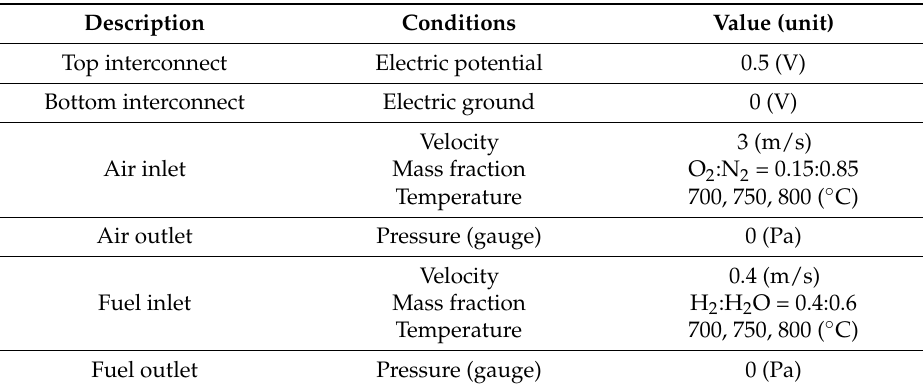
Table 2. Boundary conditions [29].